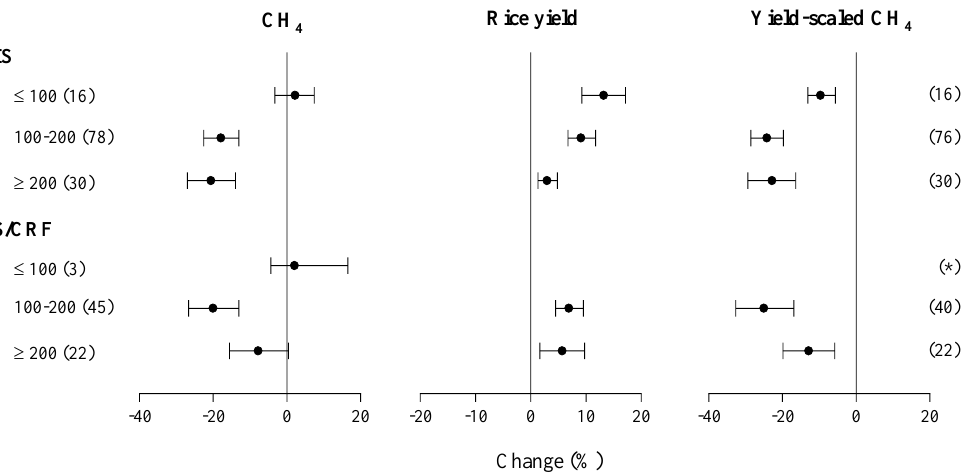
Figure 5. Impacts of N application rate on the efficacy of IS and S/CRF on CH 4 , rice yield, and yield- scaled CH 4 emission from rice fields. * the number of comparisons for rice yield and yield-scaled CH 4 was less than three.